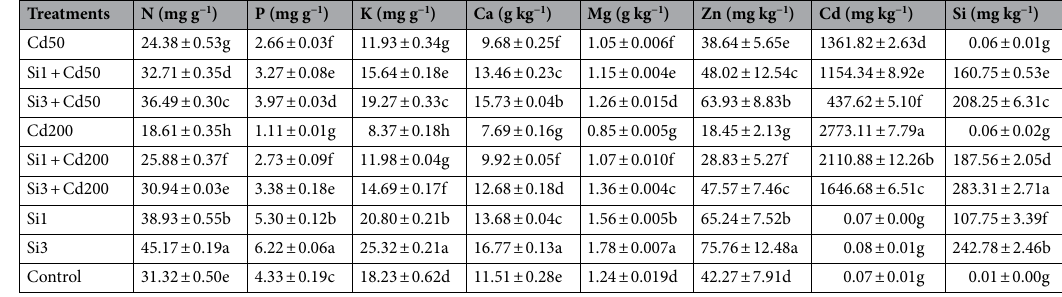
Table 2. Effect of Si and Cd on nitrogen (N) (mg g −1 ), phosphorus (P) (mg g −1 ), potassium (K) (mg g −1 ), calcium (Ca) (g kg −1 ), magnesium (Mg) (g kg −1 ), zinc (Zn) (mg kg −1 ), cadmium (Cd) (mg kg −1 ), and silicon (Si) (mg kg −1 ), contents in the roots of wheat plants. The values are expressed as the mean ± S.D. (n = 3). The different superscript letters within a column indicate significant differences at P <